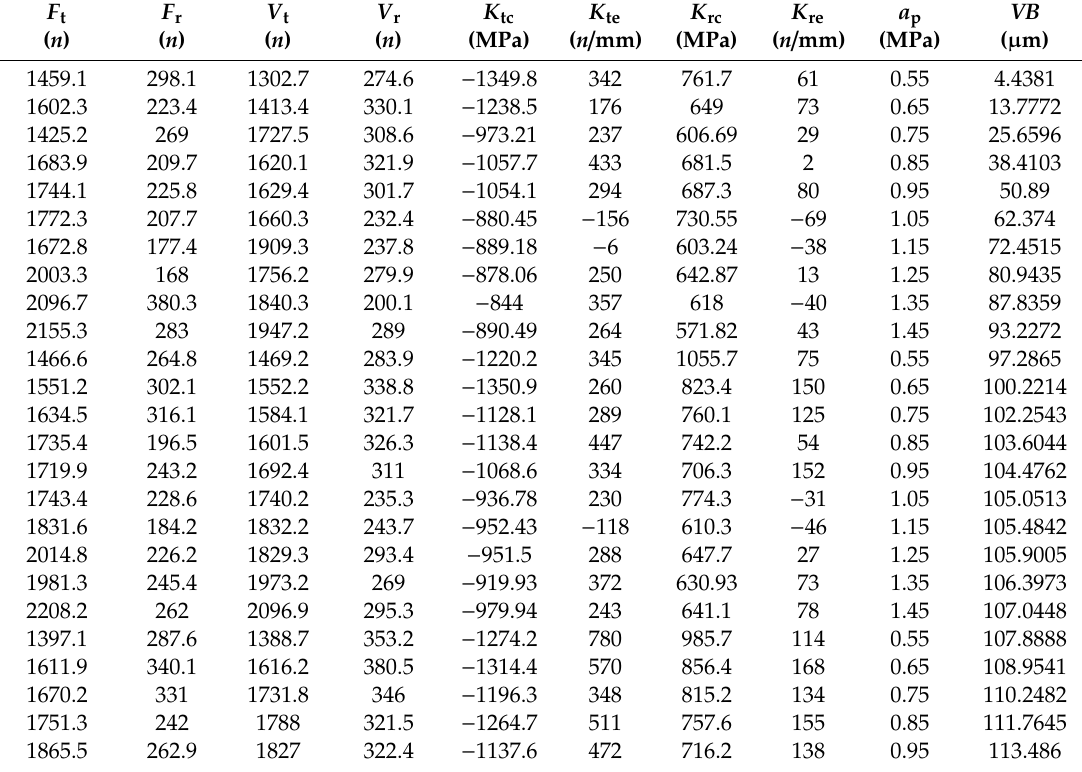
Table A1. Experimental data in varying cutting depth